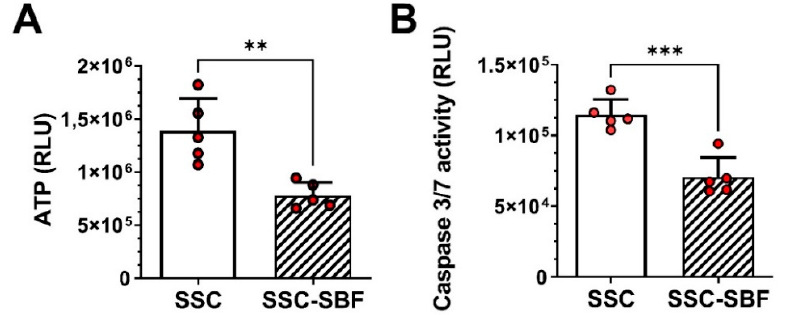
Figure 3. ( A ) ATP content and ( B ) caspase 3/7 activity of rBMSCs seeded onto untreated (SSC) and 10× SBF-treated silk scaffolds (SSC-SBF). Results are shown as the mean of five independent replicates ± SD (** p < 0.01, *** p < 0.001; unpaired t -test).